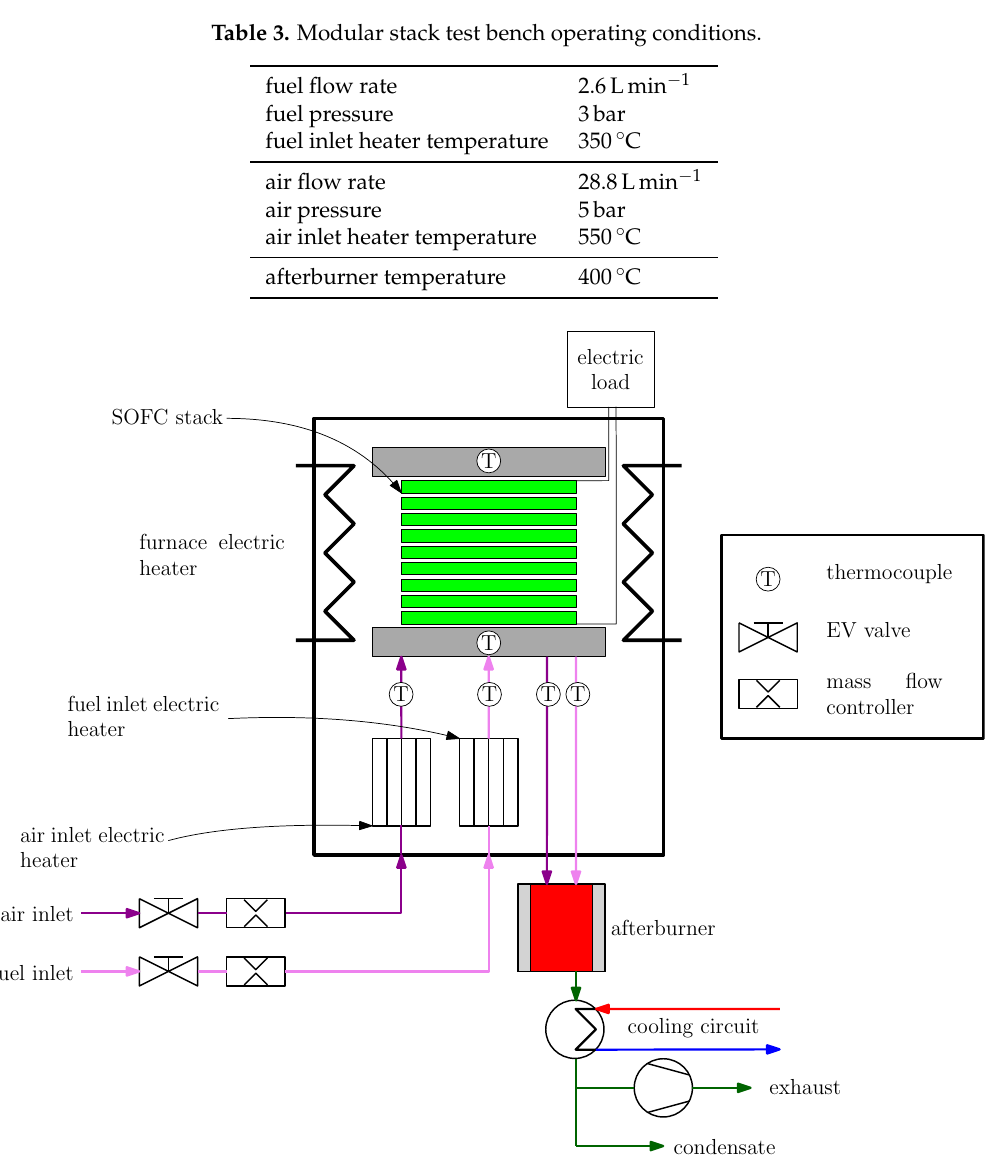
Figure 2. Configuration of the modular stack test